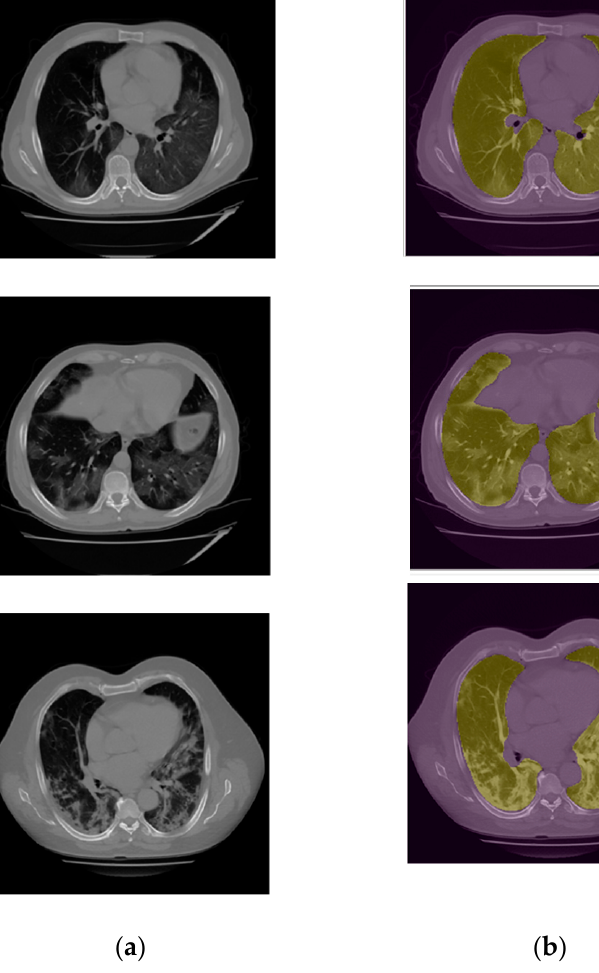
Figure 7. ( a ) Raw CT image; ( b ) Lung mask; ( c ) Infection Segmentation.